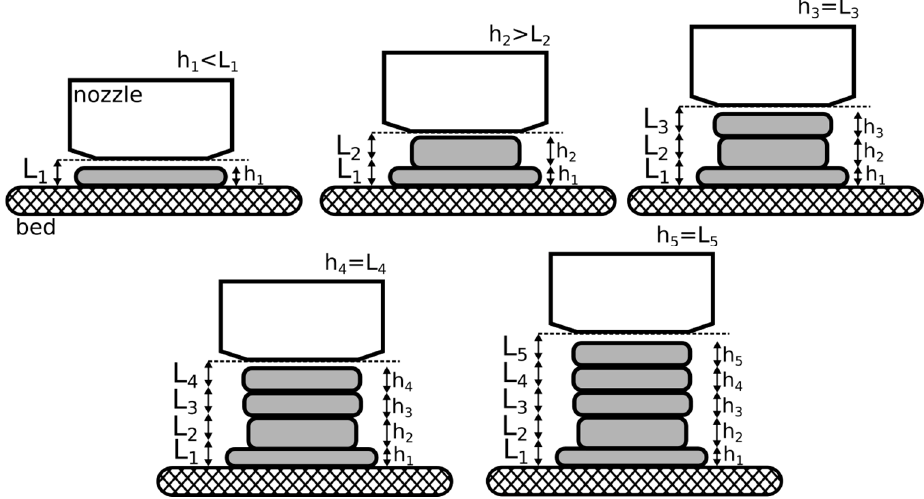
Figure 2. A series of diagrams representing the progressive deposition of multiple layers to form a single raster. The transition to stable printing such that layer thickness, h , is equal to programmed layer separation, L , is shown.